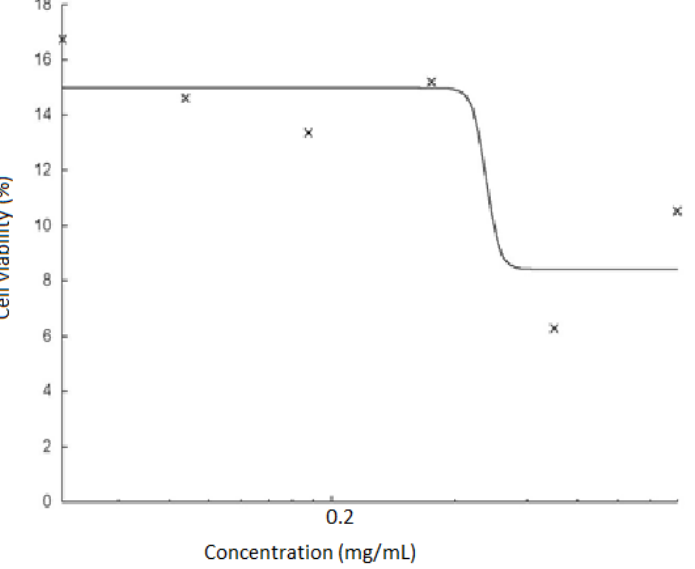
Figure 9. Graph of the percentage of cell viability of gingival fibroblasts in different concentrations of CuO NPs.